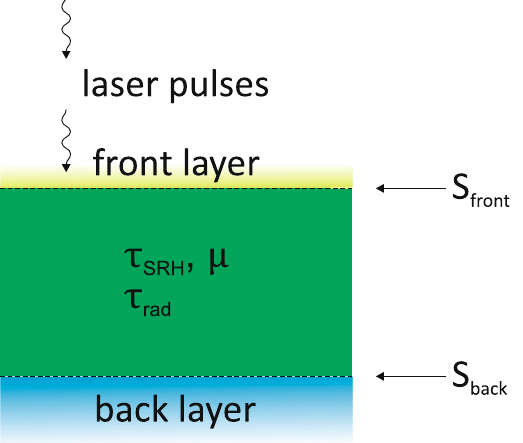
Figure 1. Model for the TRPL interpretation. Parameters describing non radiative recombination are the surface recombination velocities at the front and back side of the absorbers S front and S back as well as the bulk lifetime τ SRH and mobility μ of the CIGS absorber. The radiative recombination is taking into account with = 1.7 μ s τ rad